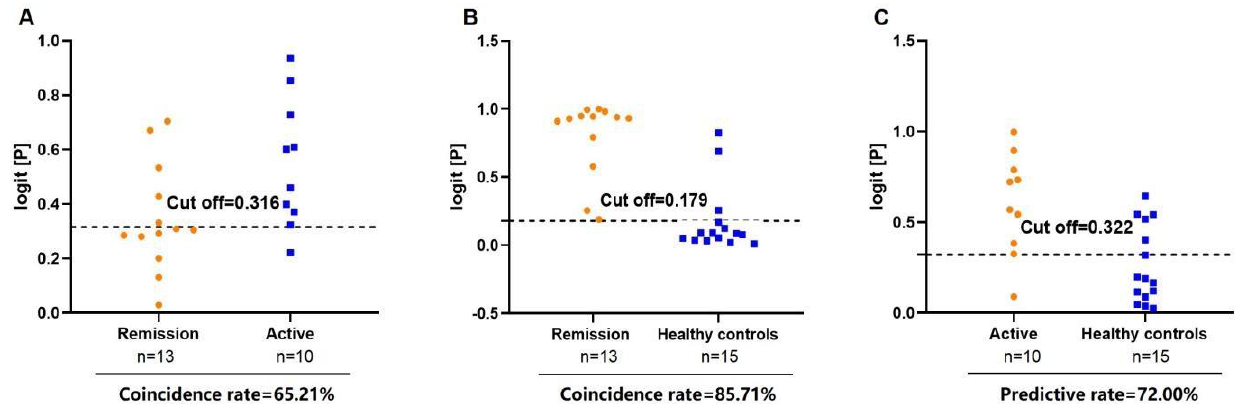
Figure 6. Diagnosis of disease activity in AS using the combination of TAG (18:0/18:1/20:0), PC (16:0e/26:4), and PC (18:1/22:6). ( A ) Diagnostic coincidence rate for the comparison between remission vs. active AS. ( B ) Diagnostic coincidence rate for the comparison between remission AS vs. HCs. ( C ) Diagnostic prediction rate for the comparison between active AS vs. HCs.